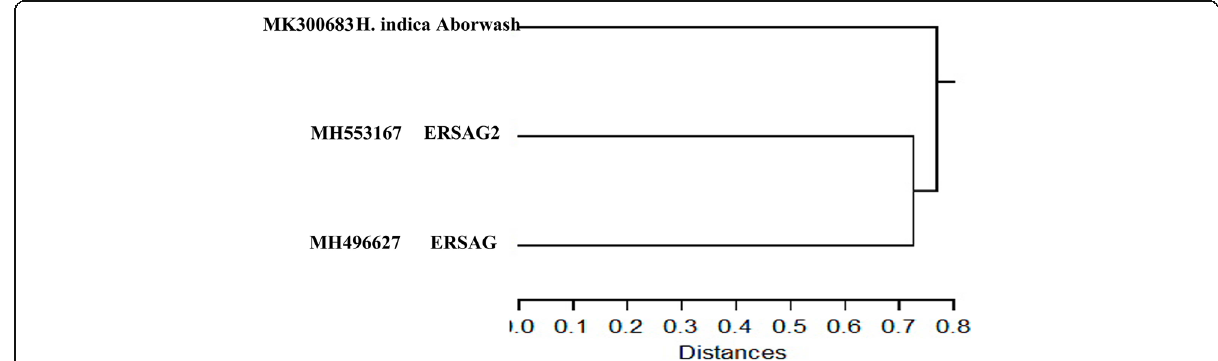
Fig. 4 Phylogenetic tree of the three Heterorhabditis indica isolates based on SCoT markers with the accession numbers of the